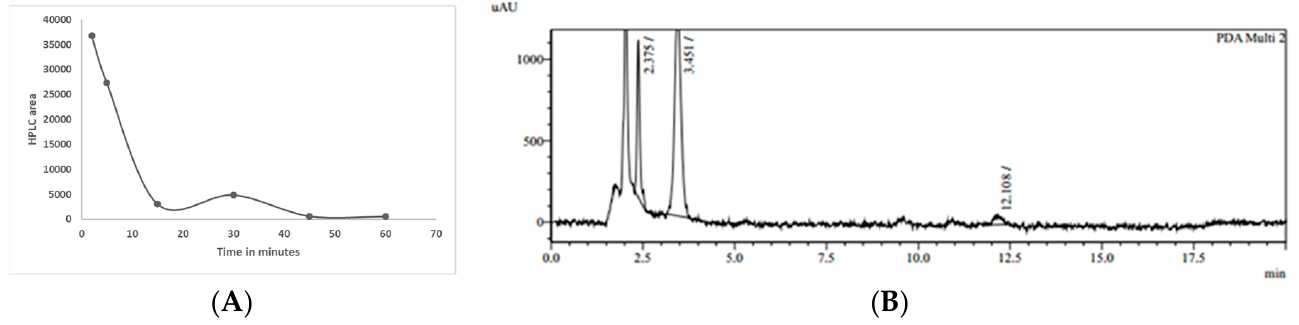
Figure 5. ( A ): Time course of TurmiZn after IV injection in rats. ( B ): Representative HPLC chroma- Figure 5. ( A ) Time course of TurmiZn after IV injection in rats. ( B ) Representative HPLC chro- matogram of TurmiZn fed to rats (5 g/Kg dose) in plasma at 4 h at 425 nm. togram of TurmiZn fed to rats (5 g/Kg dose) in plasma at 4 h at 425 nm.